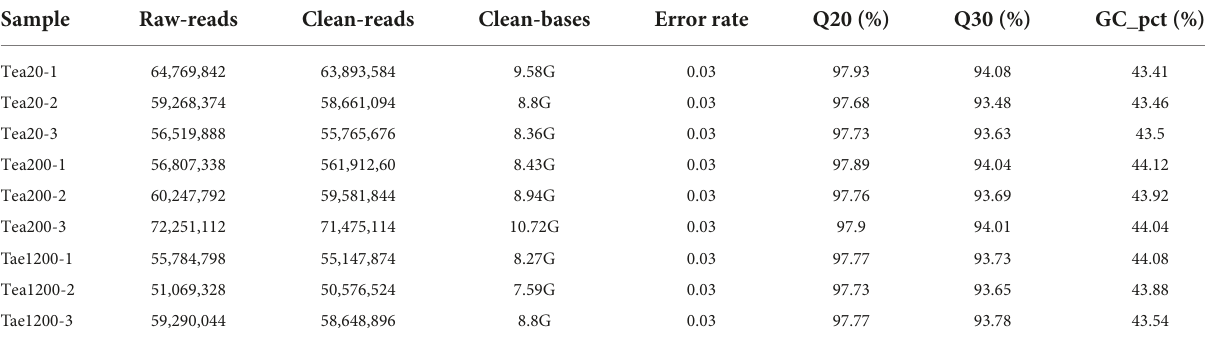
TABLE 2 Evaluation of tea transcriptome data of group